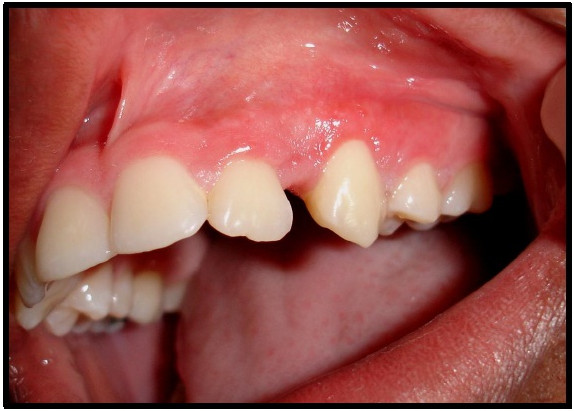
After one month.